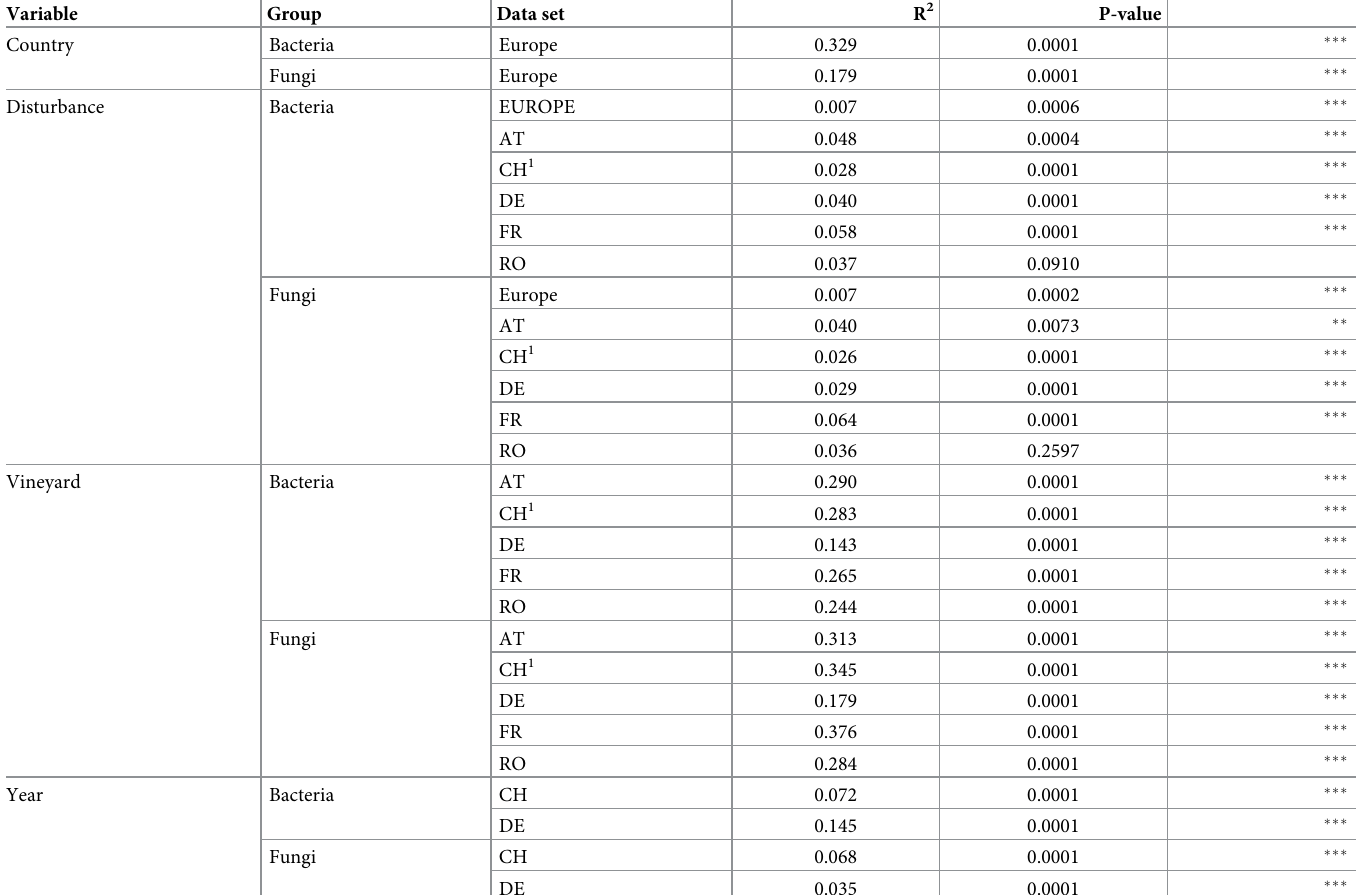
Table 3. Results of PERMANOVA of bacterial and fungal communities at European and country level (AT, Austria; CH, Switzerland; DE, Germany; FR, France; RO, Romania).